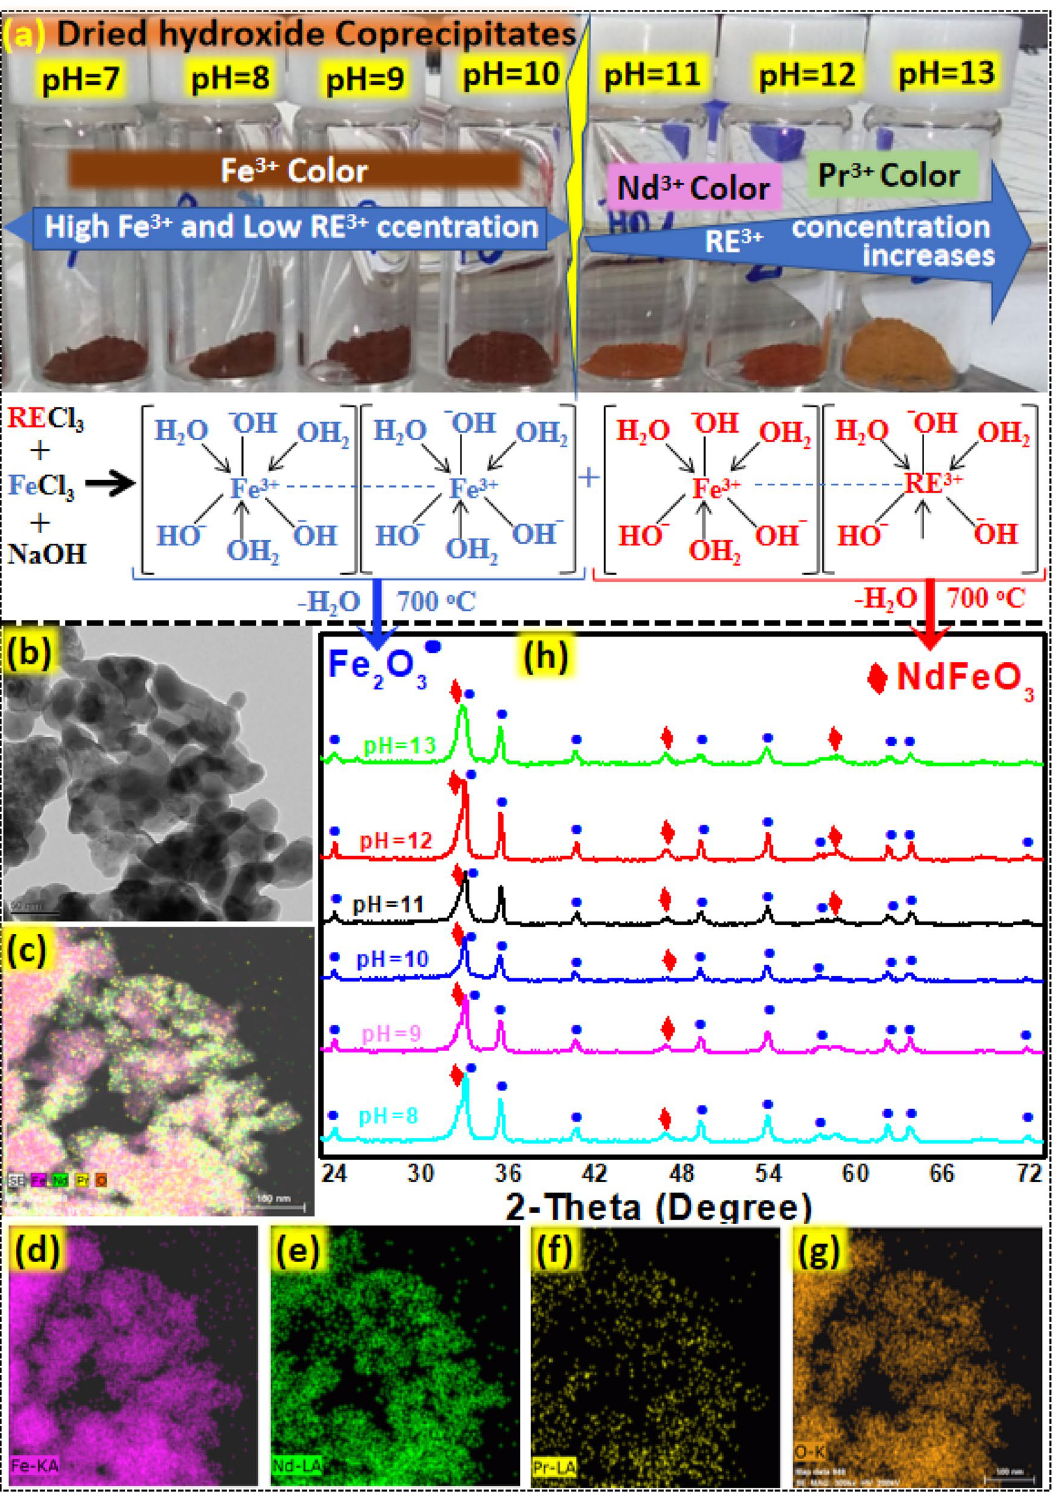
Figure 2. ( a ) Color of the dried hydroxides precipitates precipitated at pH 7–13 ( b – g ) TEM and TEM-EDS images of the RE and Fe oxide particles produced at pH 13. (h) XRD patterns for oxides of RE and Fe, produced by annealing their